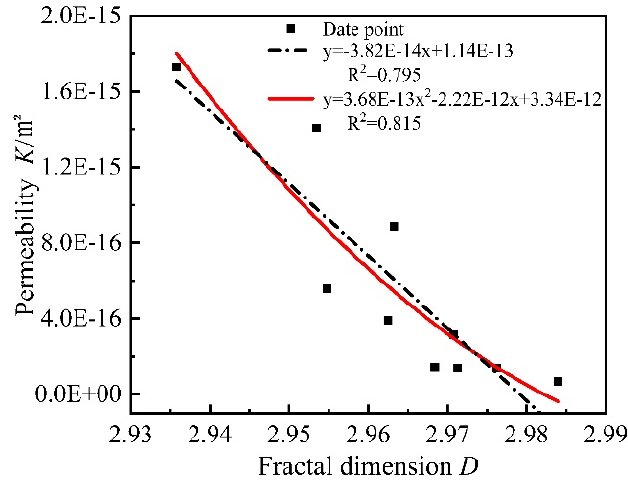
Figure 17. Relationship between permeability and fractal dimension.